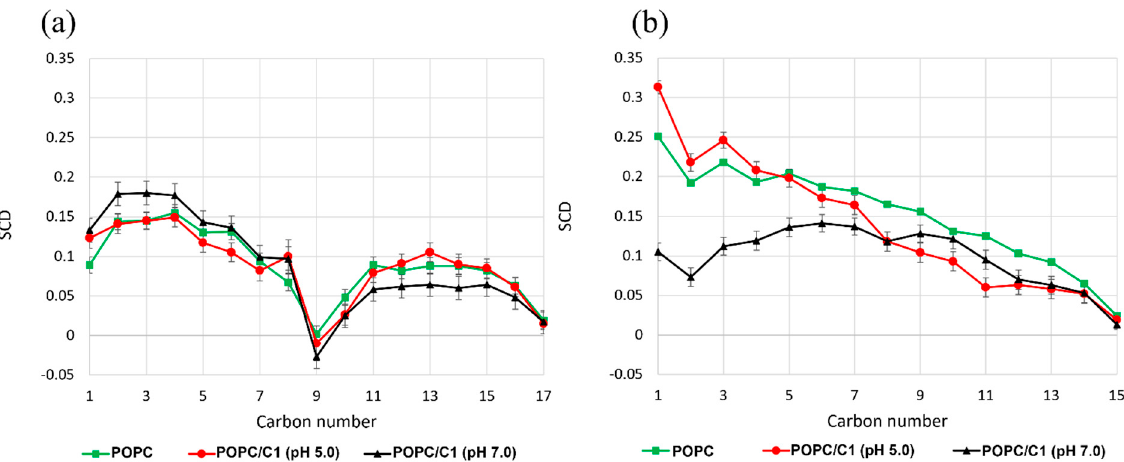
Figure 6. Deuterium order parameter (S CD ) of POPC membrane without the probe C1 (green line) and with C1 at pH = 5.0 (red line) and at pH = 7.0 (black line). ( a ) Unsaturated POPC chain; ( b ) saturated POPC chain.